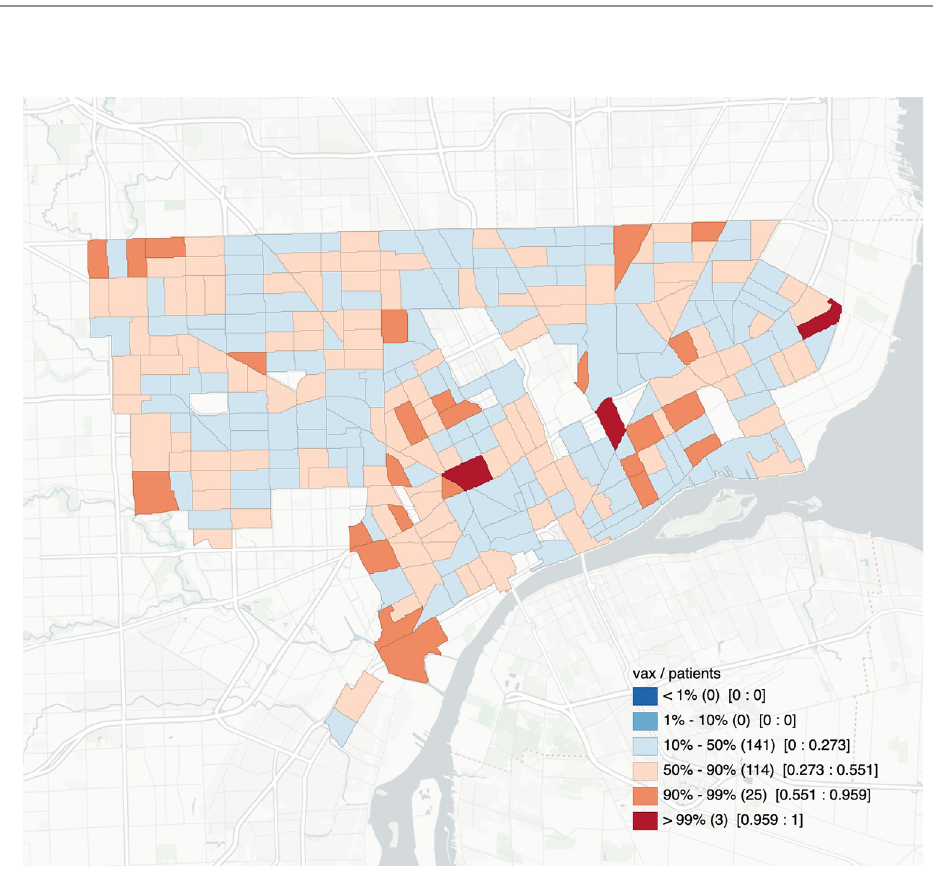
Fig 1. Influenza vaccination coverage percentiles by Census Tract in